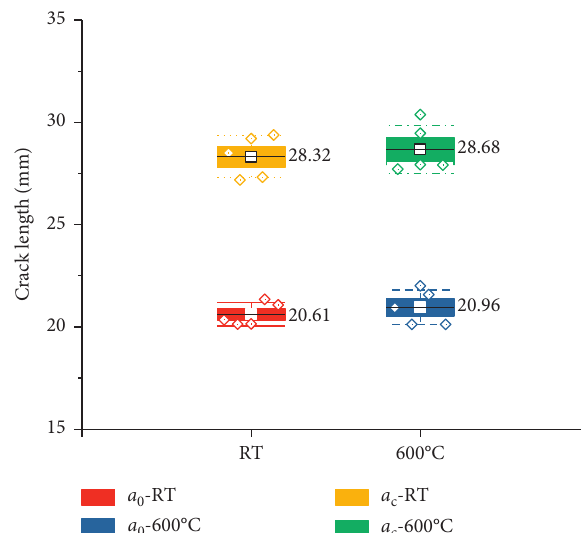
Figure 18: Initial crack length a 0 and critical effective crack length a c